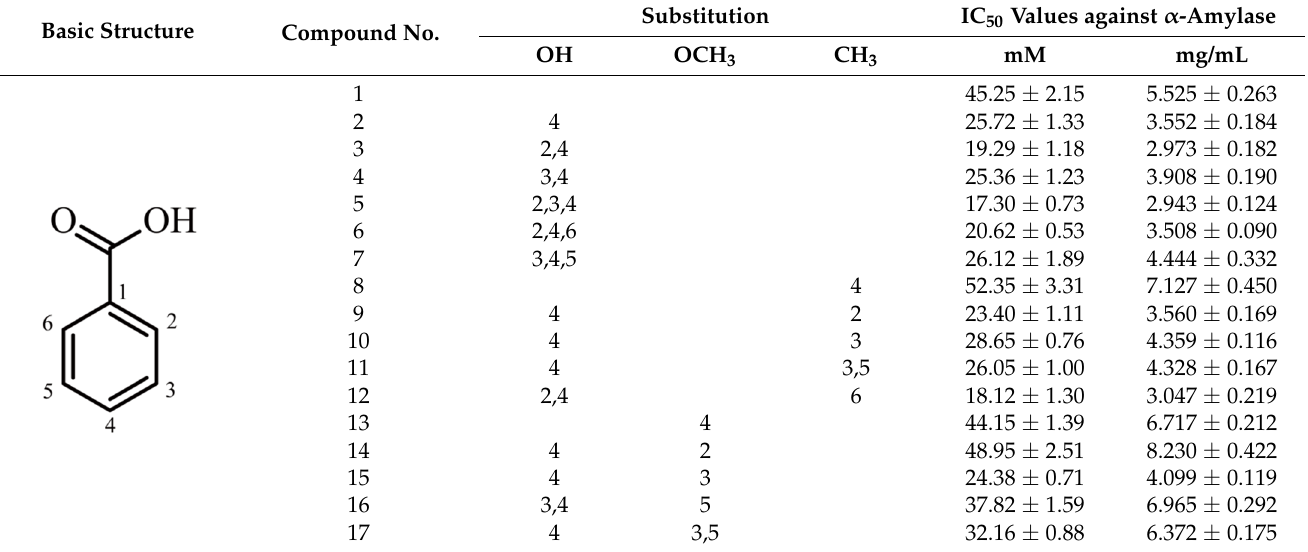
Table 1. The structures of benzoic acid and its derivatives and their IC50 values for α -amylase. Basic Structure Compound No.